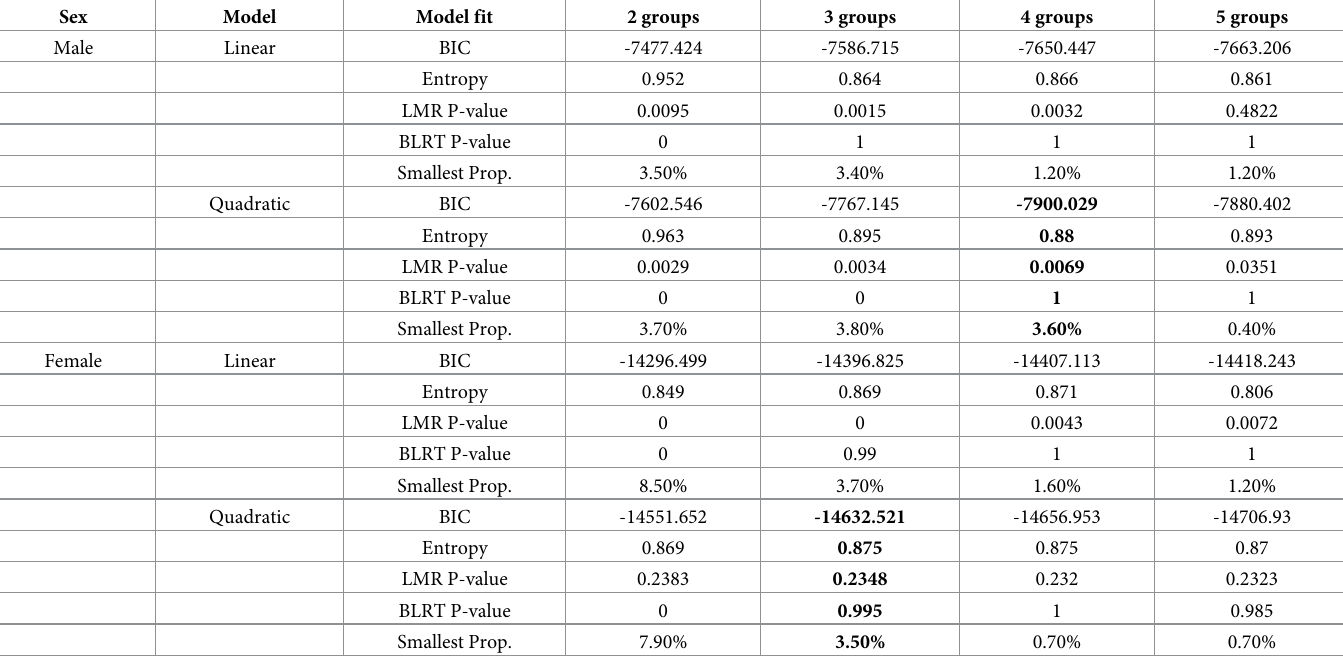
Table 1. Indices of goodness-of-fit for the latent class growth analysis.